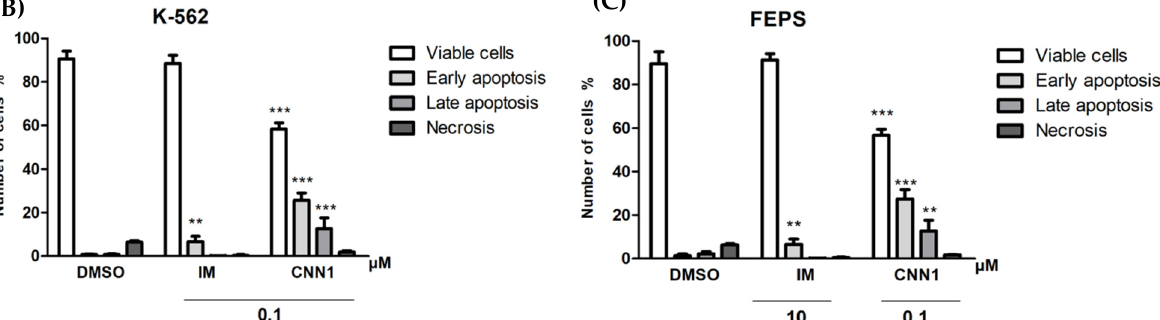
Figure 3. CNN1 increased apoptosis in K-5622 and FEPS cell lines. Percentage of apoptotic cells after 24 h treatment with CNN (0.1 µM); cells were labeled with annexin-V and PI and the result was analyzed by flow cytometry: ( A ) Representation of Dot Plot graph of the negative control (DMSO) and treated groups; ( B ) effect of CNN1 on cell death in K-562 cell line; ( C ) CNN1 induced cell death in FEPS cell line. Bars represents the percentage of viable cells, early apoptosis, late apoptosis, and necrosis. Results are expressed as mean ± SD of three independent experiments. Treated samples were compared to DMSO. Significant differences compared to control (DMSO) ** p < 0.01, *** p < 0.001 by ANOVA followed by Bonferroni post-test. Q1, necrosis; Q2, late apoptosis; Q3, early apoptosis and Q4 viable